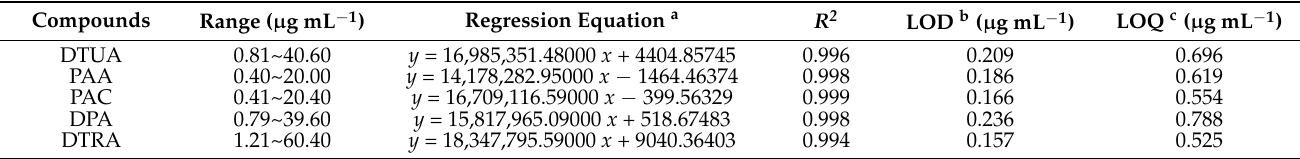
Table 1. Linear regression of the five triterpene